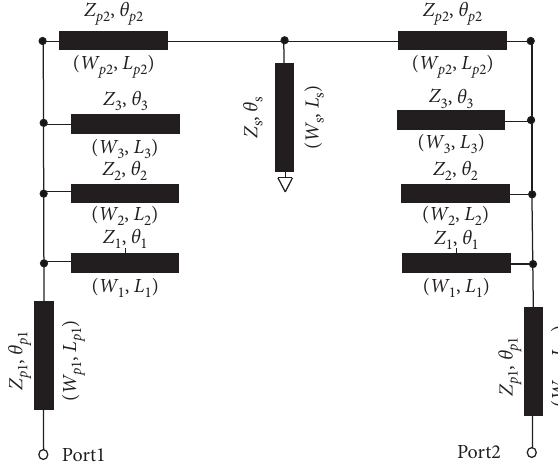
Figure 13: *e equivalent transmission line model for the pro- posed sext-band BPF.